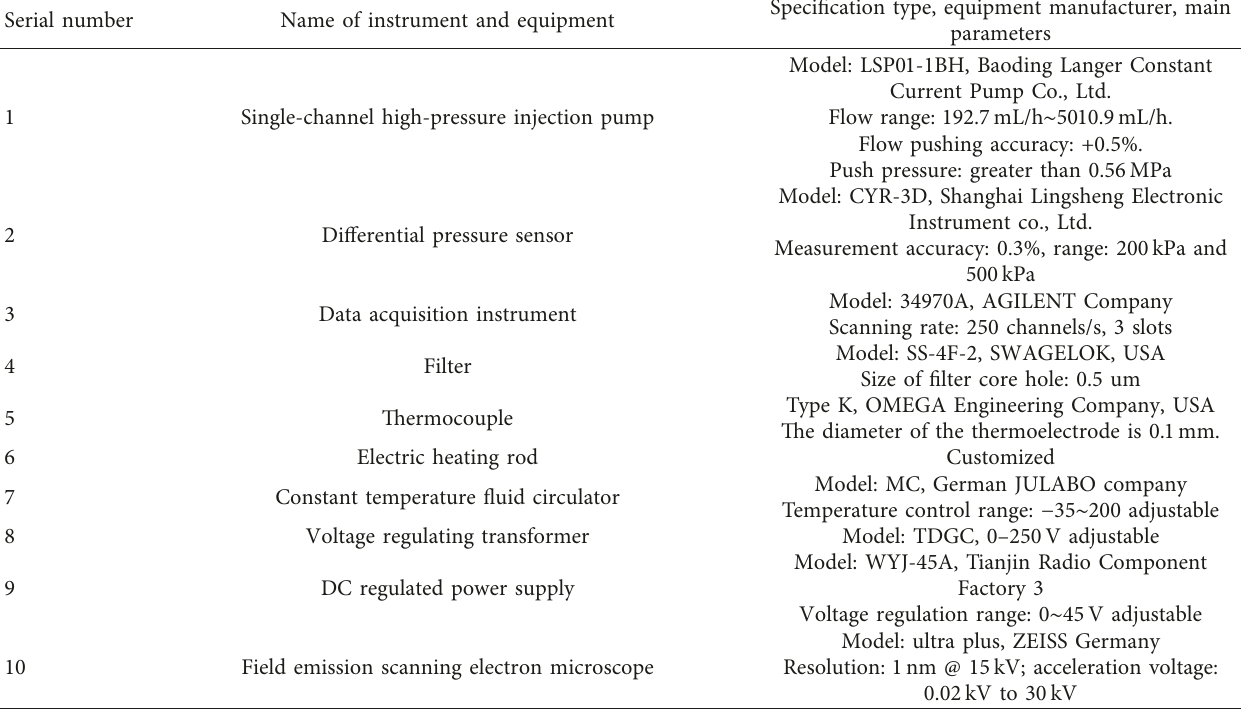
Figure 1: An experimental system for measuring liquid flow properties in microchannels: (a) schematic diagram and (b) physical Table 1: Main experimental instruments and equipment and their parameters.